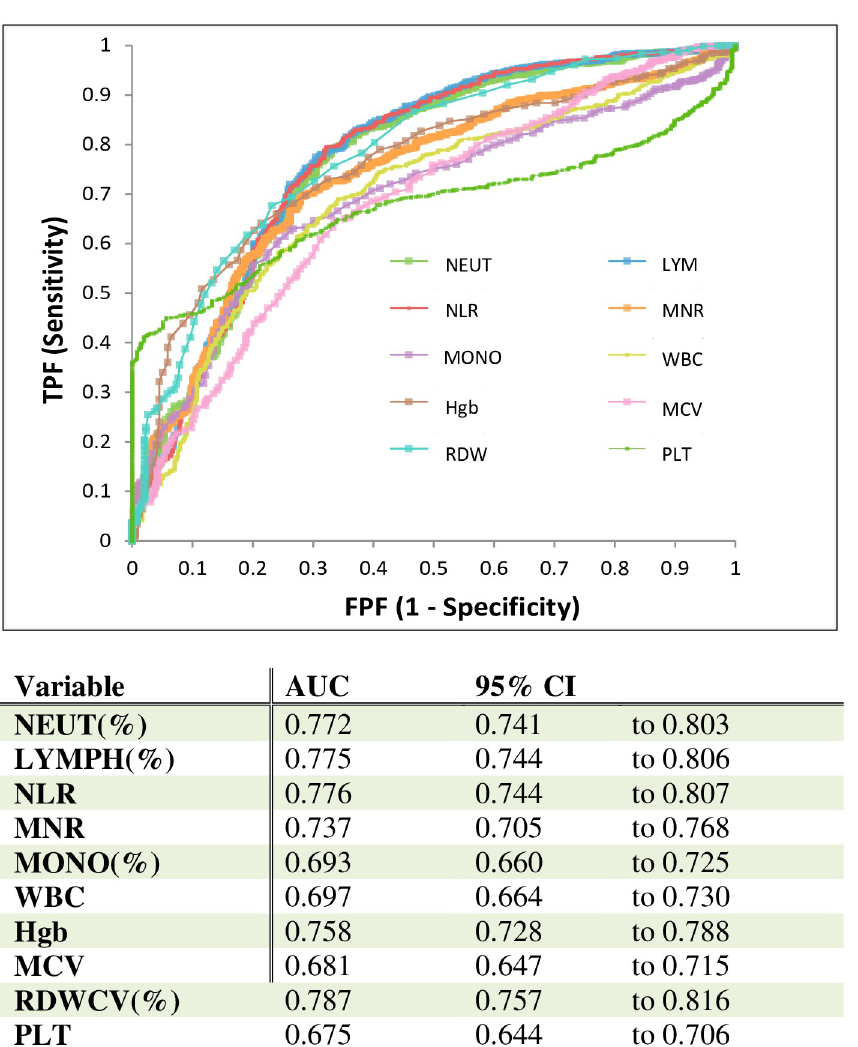
Fig 2. ROC analysis of hematological parameters in the diagnosis of severe COVID-19 patients.